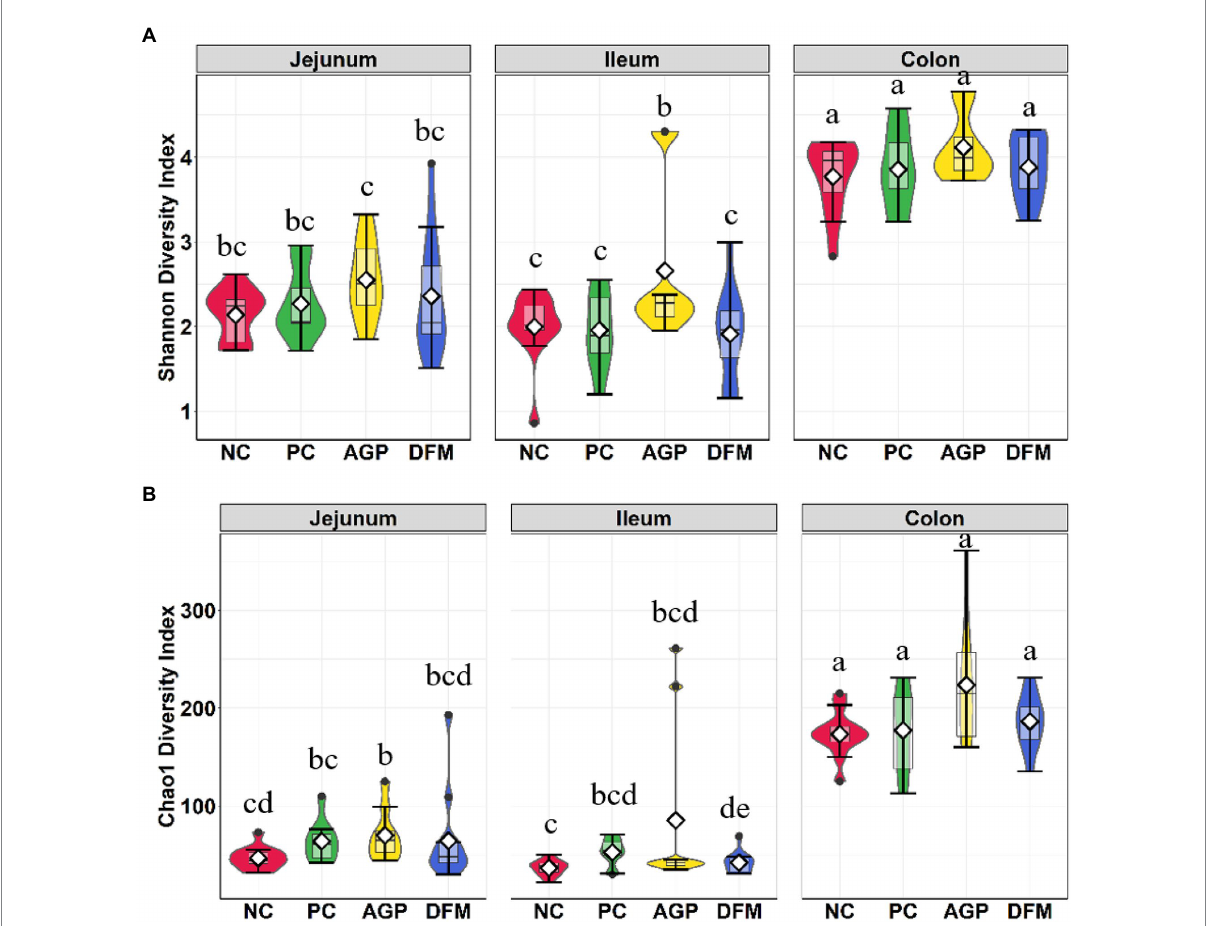
FIGURE 4 Alpha diversity as indicated by Shannon (A) and Chao1 (B) indices in intestinal digesta collected from weaned pigs challenged with enterotoxigenic E. coli . Pigs were supplemented with antibiotics (AGP) or B. subtilis (DFM). NC = negative control, PC = positive control. Violin plots are colored by diet. Data are expressed as mean (diamond) ± SEM. a-g Means without a common superscript are different ( p < 0.05). Each mean represents 9–12